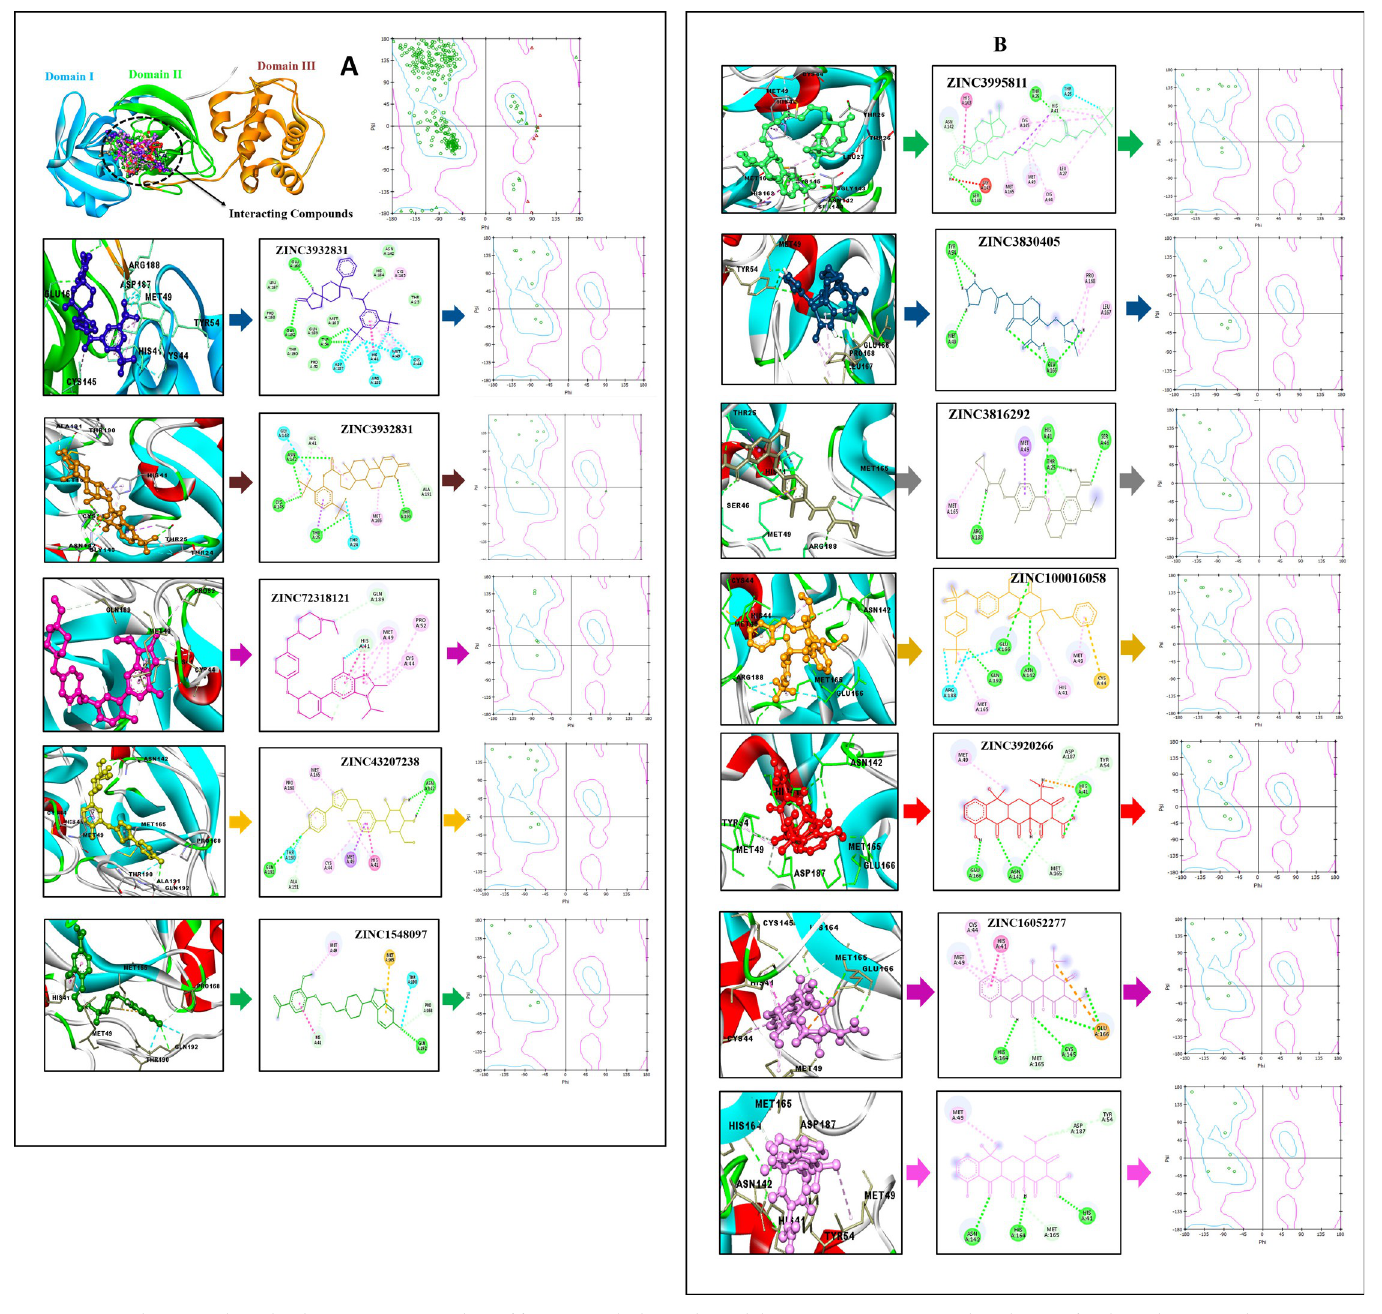
Fig 4. A: Peptide-MHC Class-I binding interacting residues of four top-ranked peptides and their sequences represented on the top of each residue. B: Binding interacting residues of eight peptides and their sequences present in different colors. Fig i, ii and iii showed interaction of docked complexes, 2D interaction of compounds and Ramachandran plot for the interaction respectively. FDA approaved compounds present as ZINC3816514 (Dark-blue), ZINC3932831 (Dark-brown), ZINC72318121 (Violet), ZINC43207238 (Yellow), ZINC1548097 (Green), ZINC3995811 (Light-green), ZINC3830405 (Slate-blue), ZINC3816292 (Dim-grey), ZINC100016058 (Orange), ZINC3920266 (Red), ZINC16052277 (Purple) and ZINC84441937 (Pink). Conserved residues are shown in Table